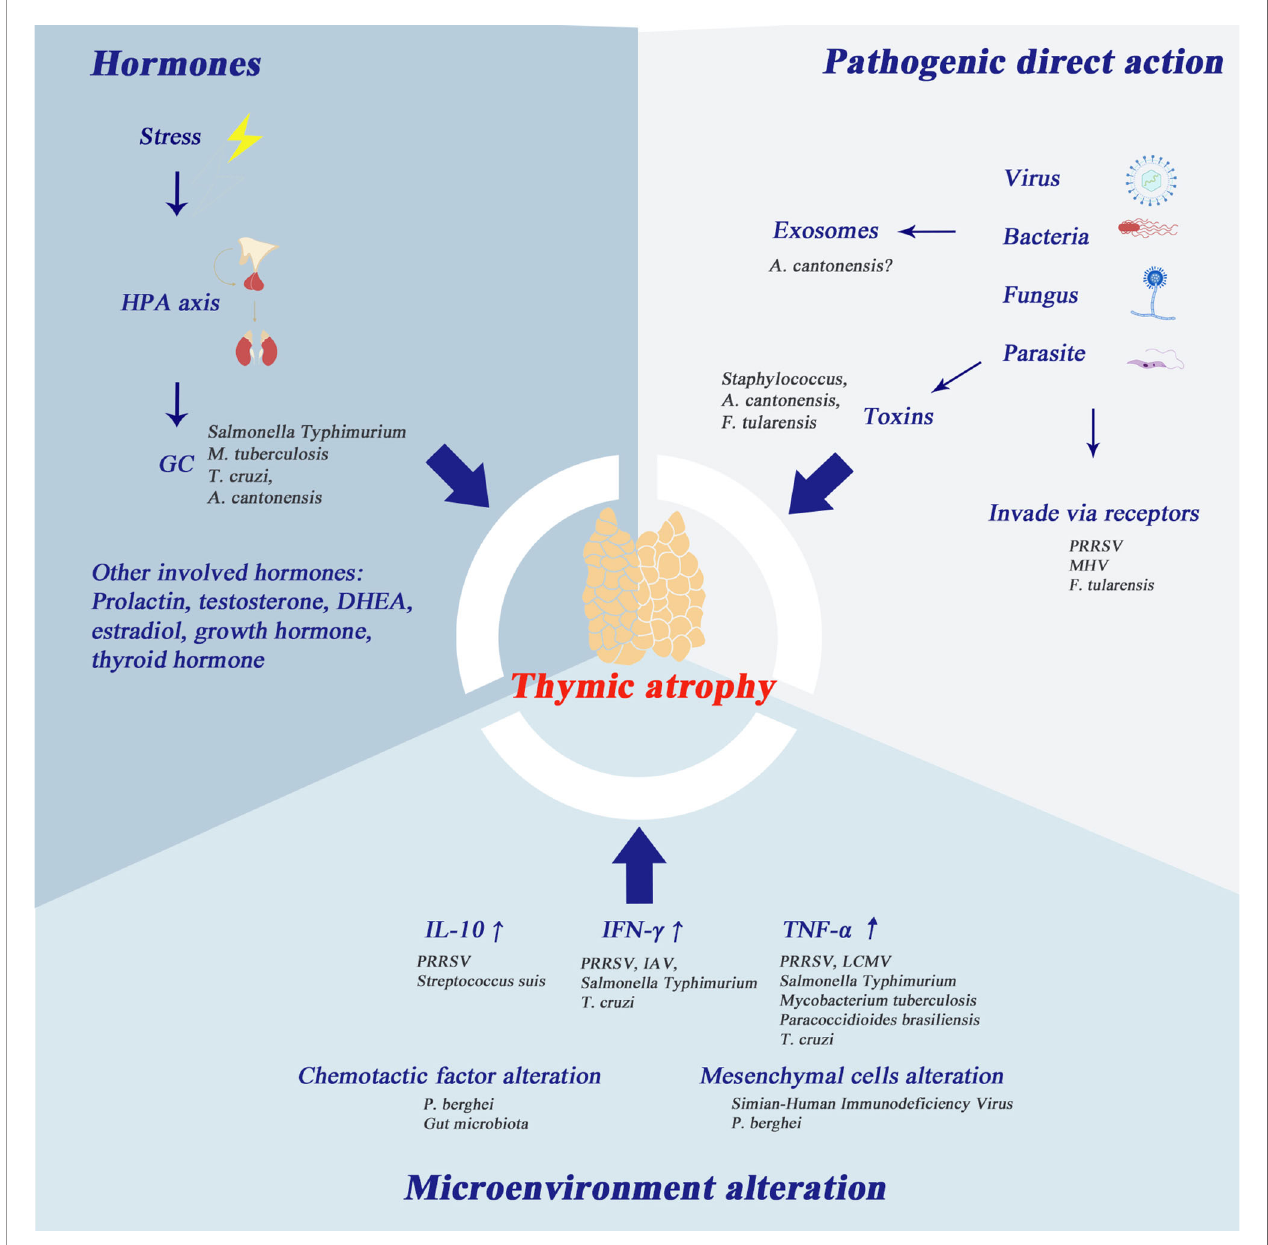
FIGURE 2 | Mechanisms of infection-induced thymic atrophy. This fi gure summarizes the three main mechanisms of infection-related thymic atrophy and lists the characteristic pathogens corresponding to each mechanism. 1) The hypothalamic-pituitary-adrenal (HPA) axis plays an important role in infection-induced thymic atrophy. Glucocorticoids can induce apoptosis of thymocytes, especially DP thymocytes. In addition, other hormones mentioned in the picture are also thought to be involved in thymic atrophy. 2) At the molecular level, the change of thymus microenvironment is one of the major changes associated with thymic atrophy, and the main cytokines involved are IL-10, IFN- g and TNF- a . 3) Some pathogens take the thymus as the target organ and directly invade the thymus. In addition, the products of pathogens, such as toxins, soluble antigens, and exosomes, can also play an important role in thymic